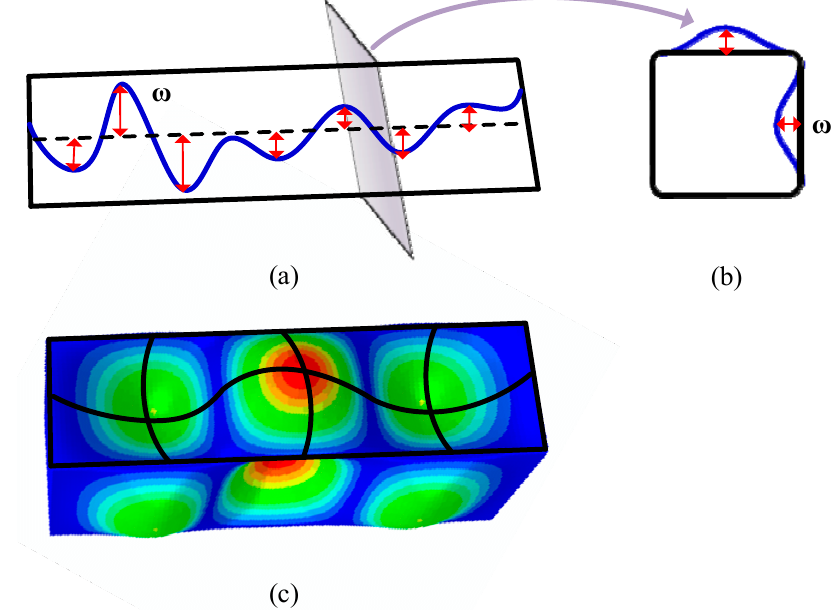
Figure 4. Localized imperfection ( ω ). ( a ) Random ω along longitudinal centerline of the surface; ( b ) ω in transverse direction (convexity/concavity); ( c ) idealized ω obtained from buckle analysis.